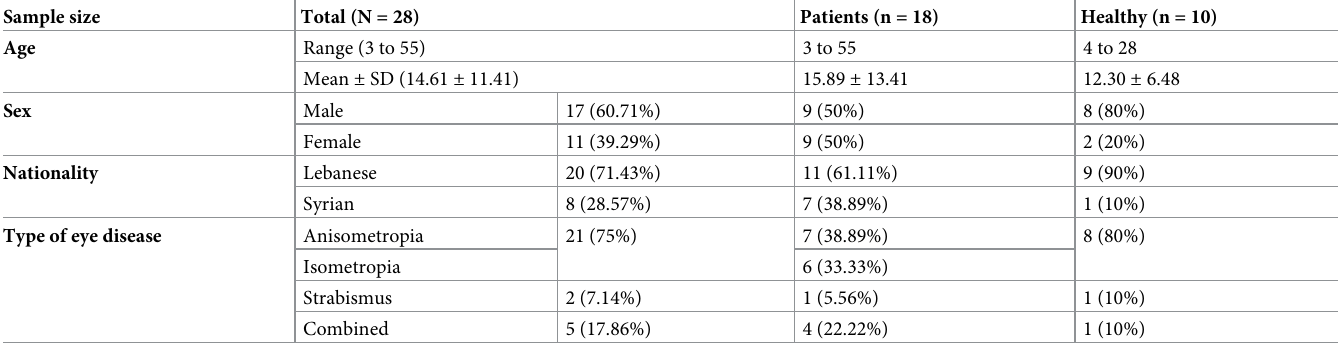
Table 2. Demographics and clinical characteristics of